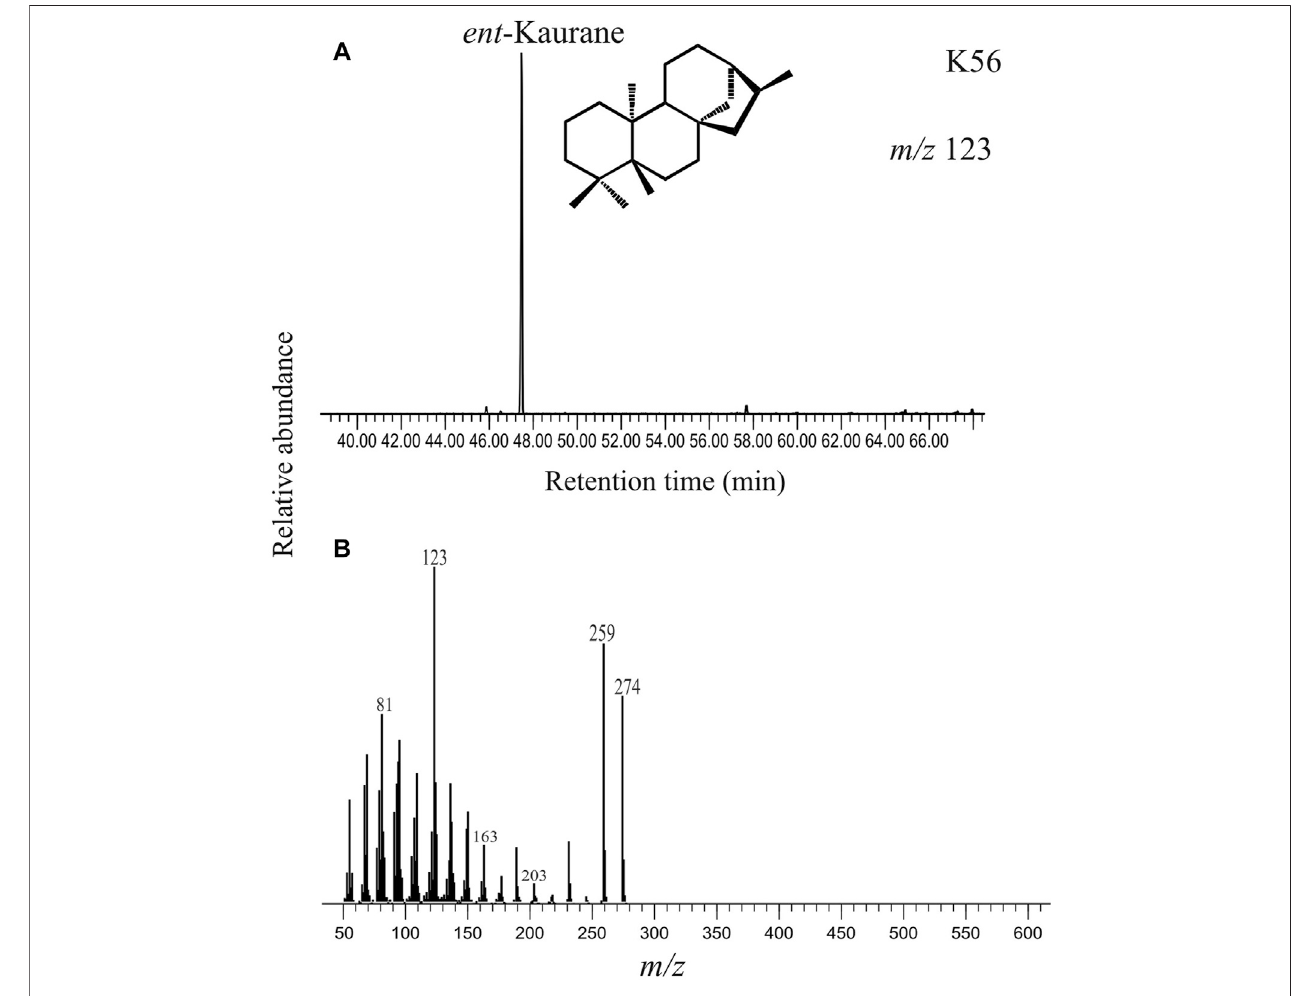
FIGURE 5 | (A) Selected ion chromatogram at m/z 123 depicting the peak for the diterpane compound detected as ent -kaurane in the saturated hydrocarbon fractionextractedfromthestudiedsediment(K56, ∼ 3733 cal yrBP).Thestructureof ent -kauraneisprovided. (B) Themassspectrumof ent -kauranewiththebasepeak at m/z 123 and major mass fragments at m/z 259 and m/z 274 are